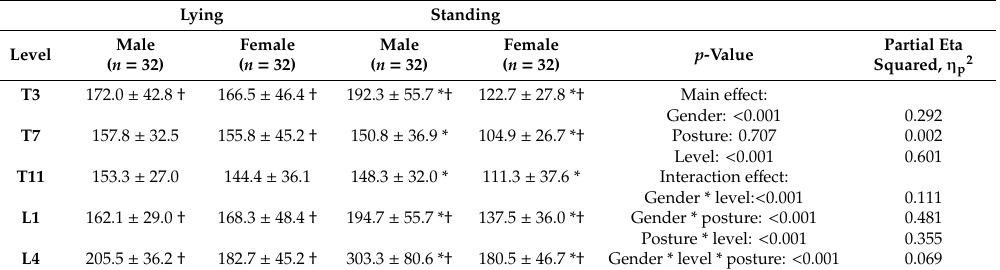
Partial Eta Squared, η p2